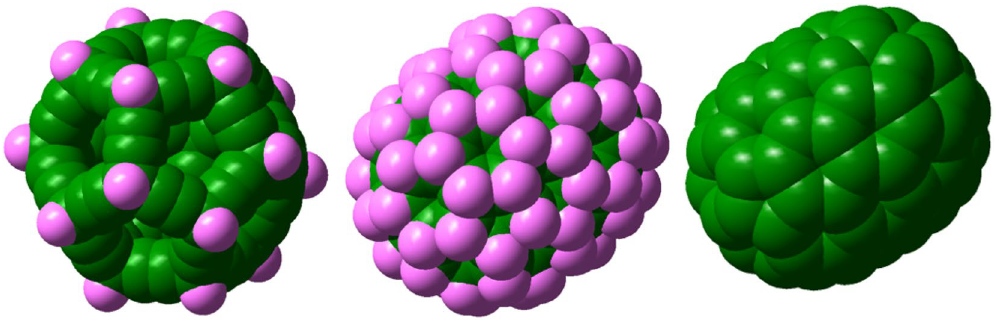
Figure 8. Three carbon nanocages made of 80 carbons: fulleryne, C 80 H 20 , fullerane, C 80 H 80 and fullerene, C 80 .